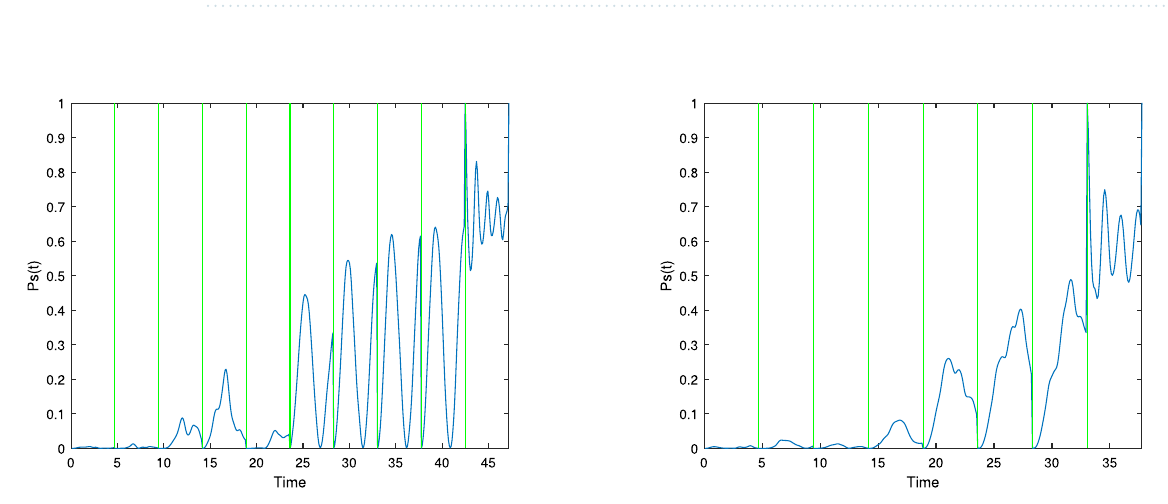
Figure 4. Probabilities of measuring | s � depicting the behavior of the complete algorithm for 2 randomly selected 10 variables 3-SAT instances with a unique solution from our database. Vertical green lines show when a measurement took